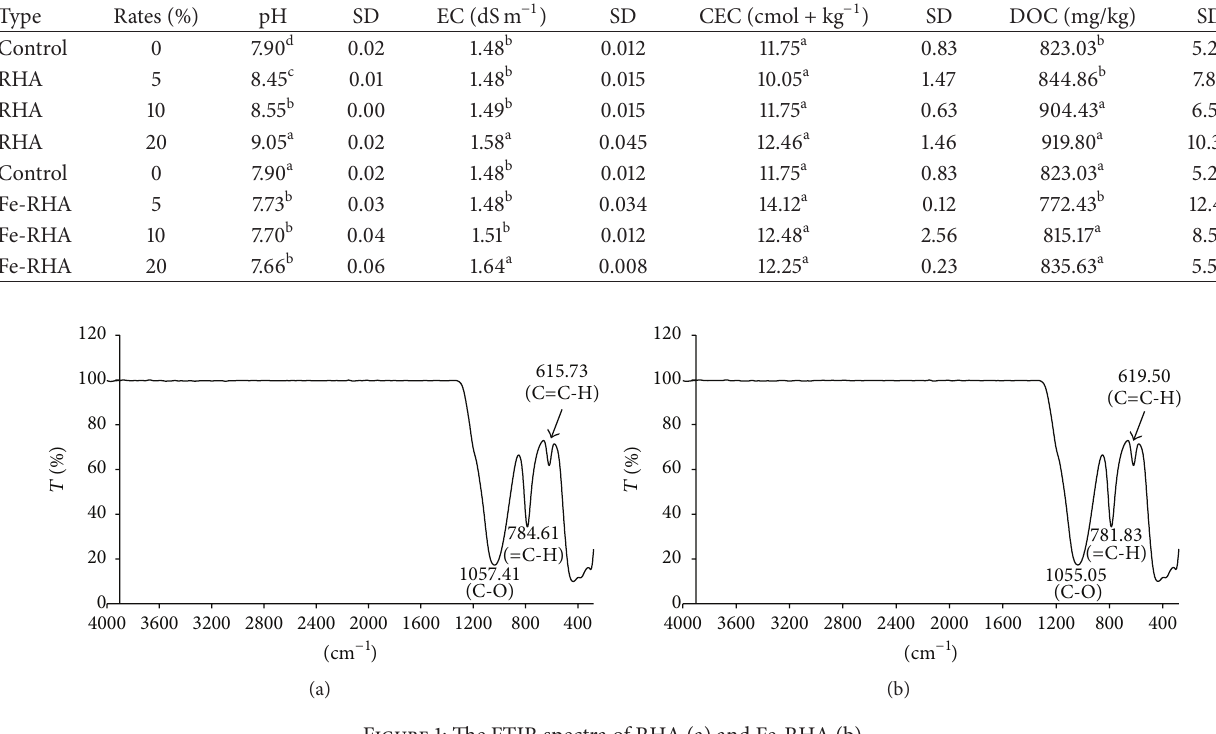
Figure 1: The FTIR spectra of RHA (a) and Fe-RHA (b).